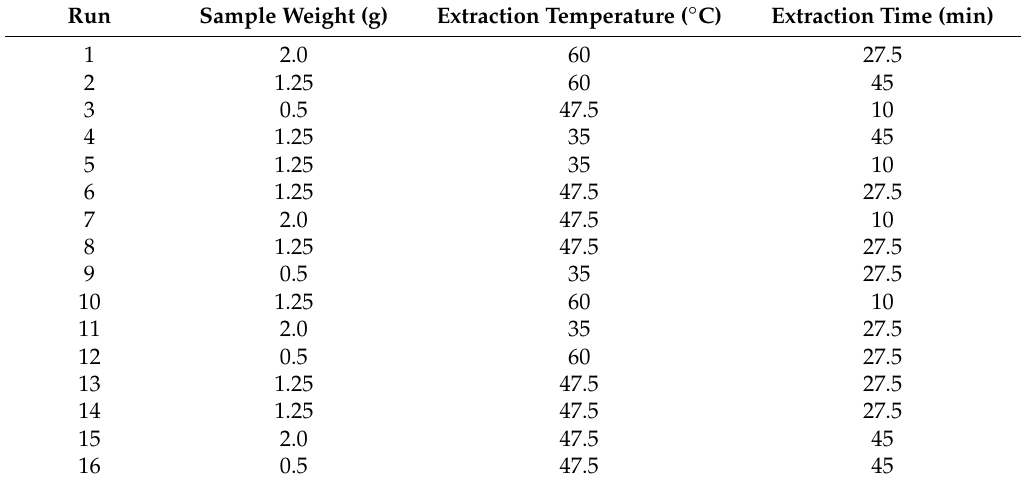
Table 1. Box–Behnken experimental design showing the levels of each independent factor (sample weight, extraction temperature and extraction time) for the Headspace Solid-Phase Microextraction in combination with Gas Chromatography-Mass-Spectrometry (HS-SPME) extraction of target compounds in Raspberry